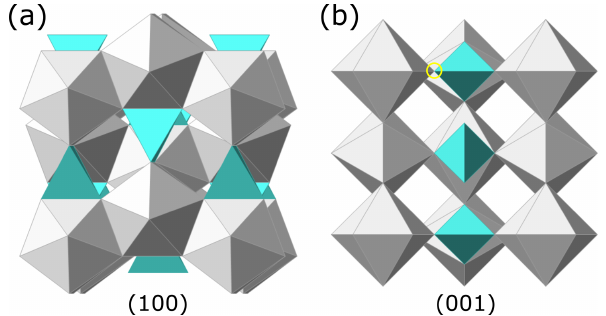
Figure 19. The zircon crystal structure (Hazen and Finger, 1979; Finch and Hanchar, 2003) rendered using CrystalMaker ® software. ZrO 8 polyhedra are in light gray and SiO 4 tetrahedra are in teal. (a) Projection on (100) looking down the a axis. (b) Projection on (001) looking down the c axis. The yellow circle highlights the corner-sharing bonds between the SiO 4 tetrahedra and the ZrO 8